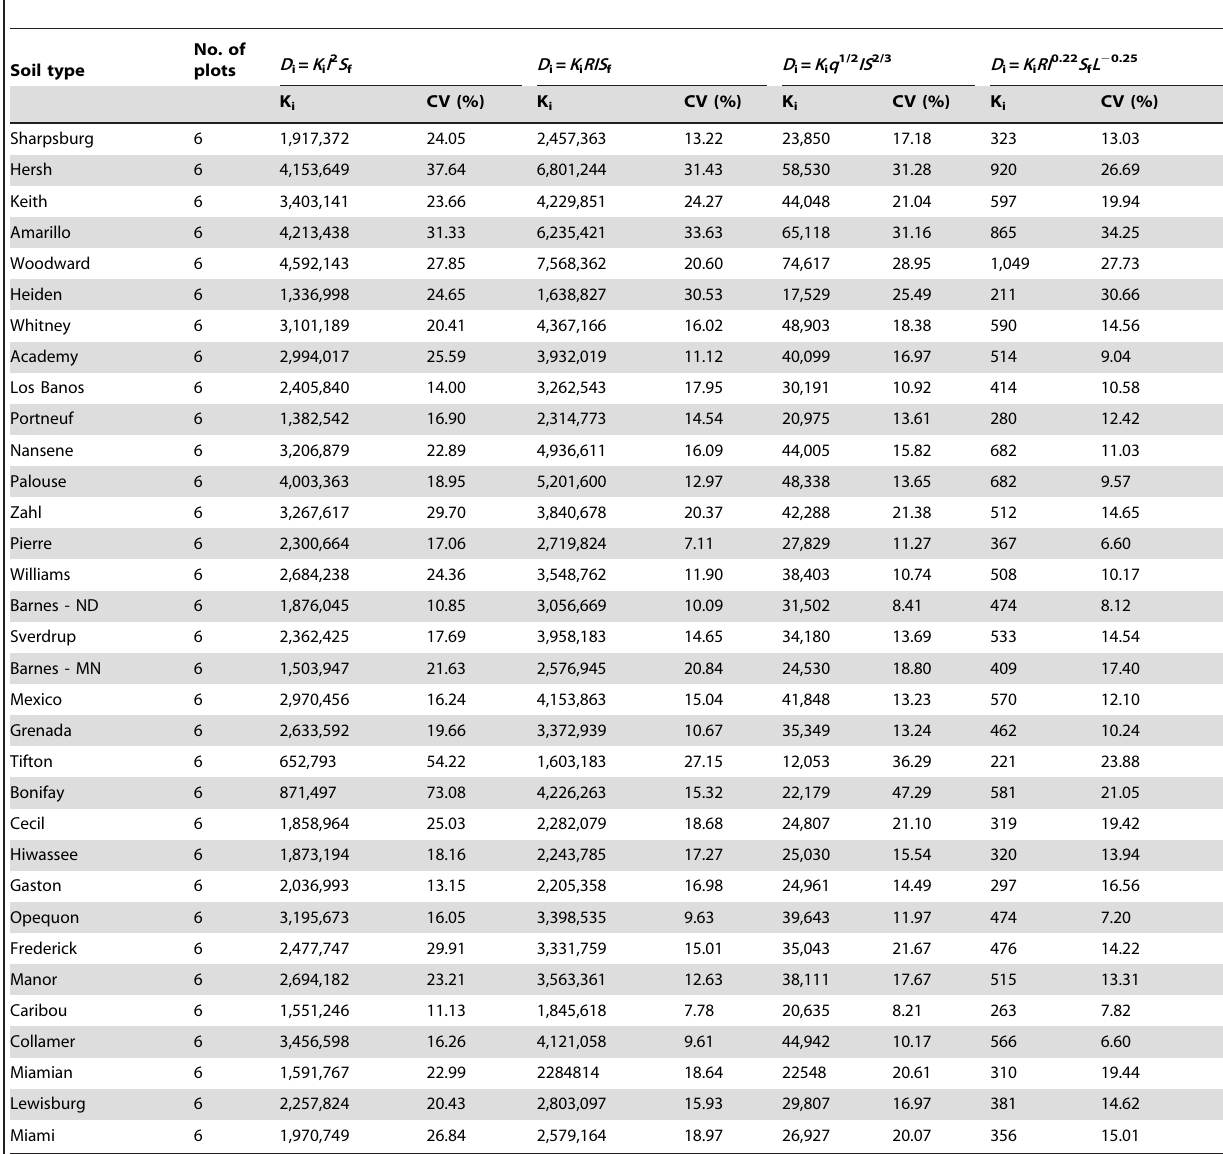
Table 6. Interrill erodibility and its CV from the different interrill erosion equations for the experimental data from the WEPP cropland soil field interrill erodibility